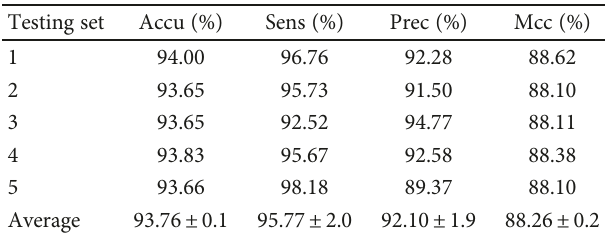
Table 3: 5-Fold cross-validation results using the proposed method on the H. pylori